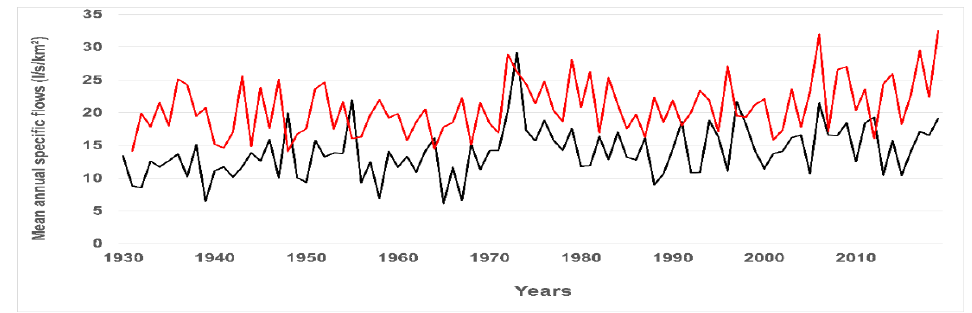
Figure 3. An example of interannual variability of mean annual flows from 1930 to 2019. Red curve: Du Nord River; black curve: Châteaugay River.